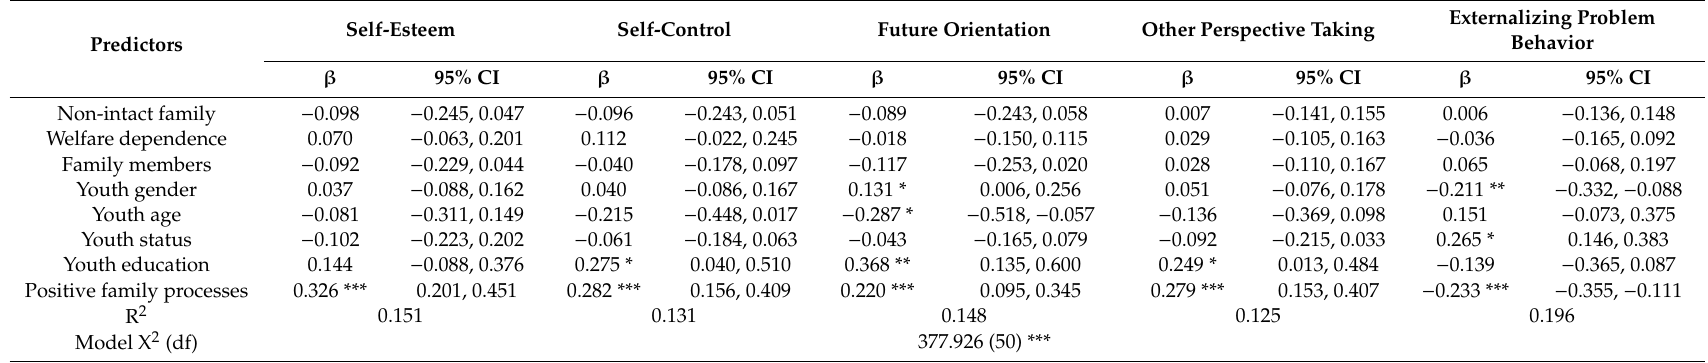
Table 3. Multivariate linear regression modeling predicting self-esteem, self-control, future orientation, other perspective taking and externalizing problem behaviors of youth by positive family